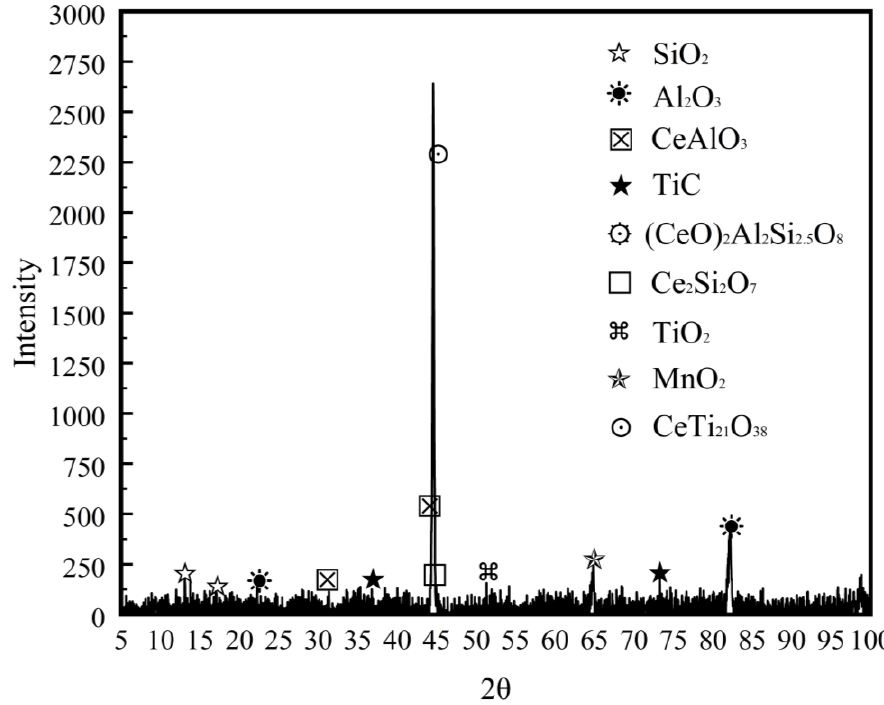
Figure 6. XRD image of deposited metals.